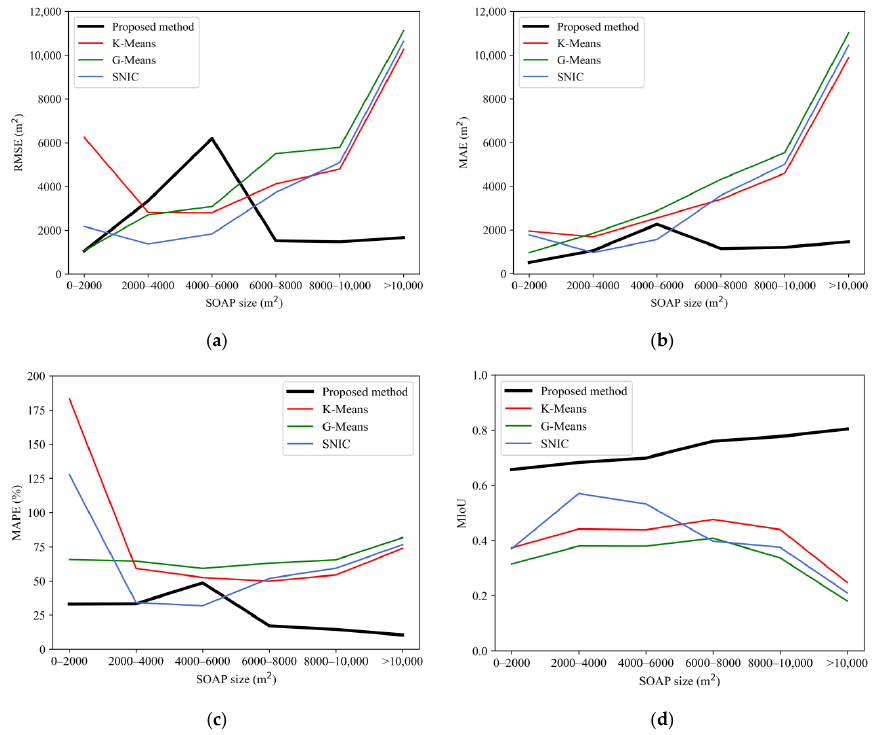
Figure 12. Segmentation accuracies comparison between the proposed K-Means, G-Means, and SNIC methods in different SOAP size classes: ( a ) RMSEs of the four methods for SOAPs in different size ranges; ( b ) as in ( a ), but for the MAEs; ( c ) as in ( a ), but for the MAPEs; ( d ) as in ( a ), but for the MIoUs.